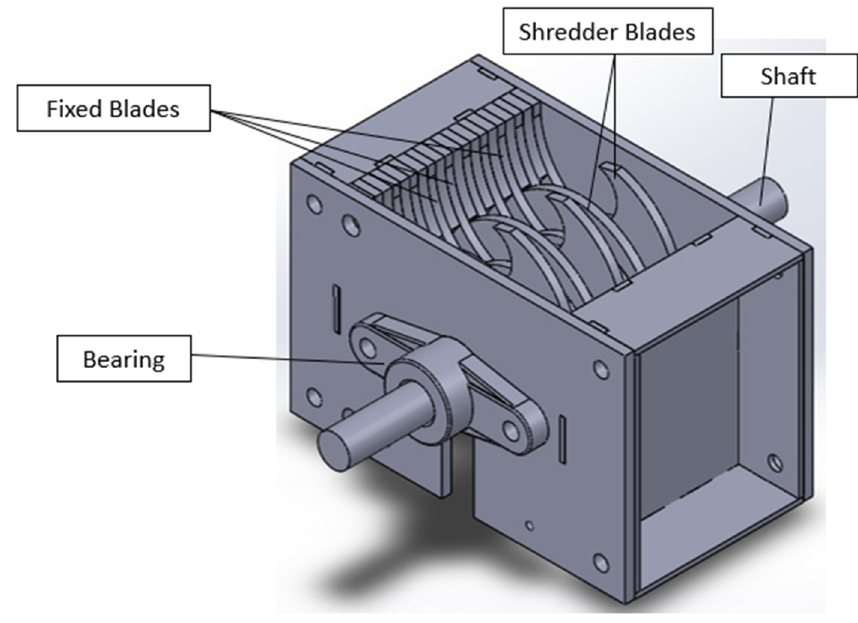
Figure 3. Single ‐ shaft shredder machine. Figure 3. Single-shaft shredder